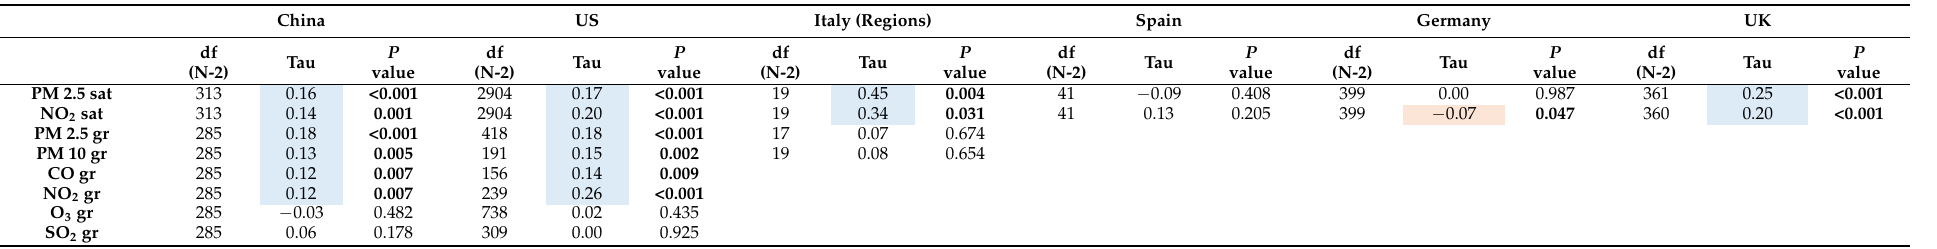
Table 4. Correlation coefficients between COVID-19 mortality rates and air quality variables. Significant Kendall correlations with p -values < 0.05 are shown in bold; blue and red shadings indicate positive and negative correlations,